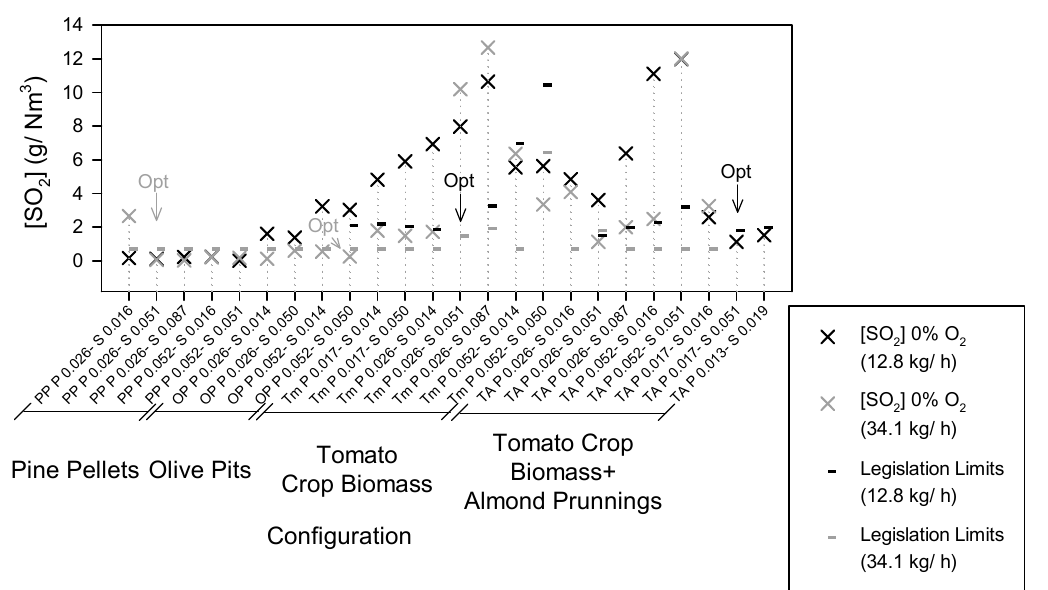
Figure 9. [SO 2 ] 0% O 2 observed for each biomass type, their corresponding fuel rates, and the primary and secondary air supply rates (*Legislation limit outside the graph scale. Opt: Configuration identified as optimum).